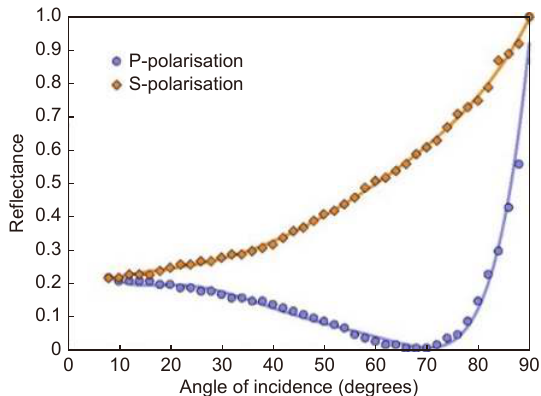
Fig. 14 | Reflectance as a function of the incidence angle and polarisation of polycrystalline ZnSe showing that Brewster’s angle is near 70° as